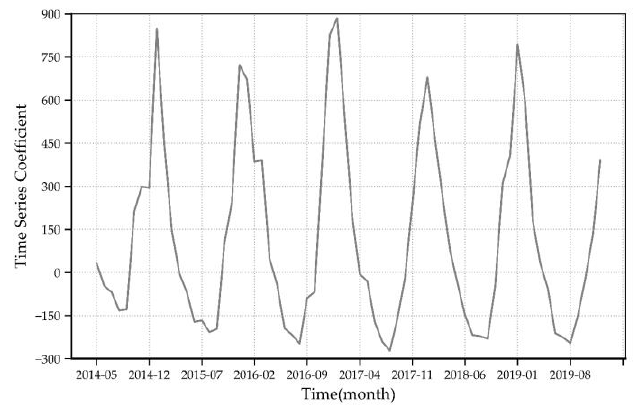
ffi cients during